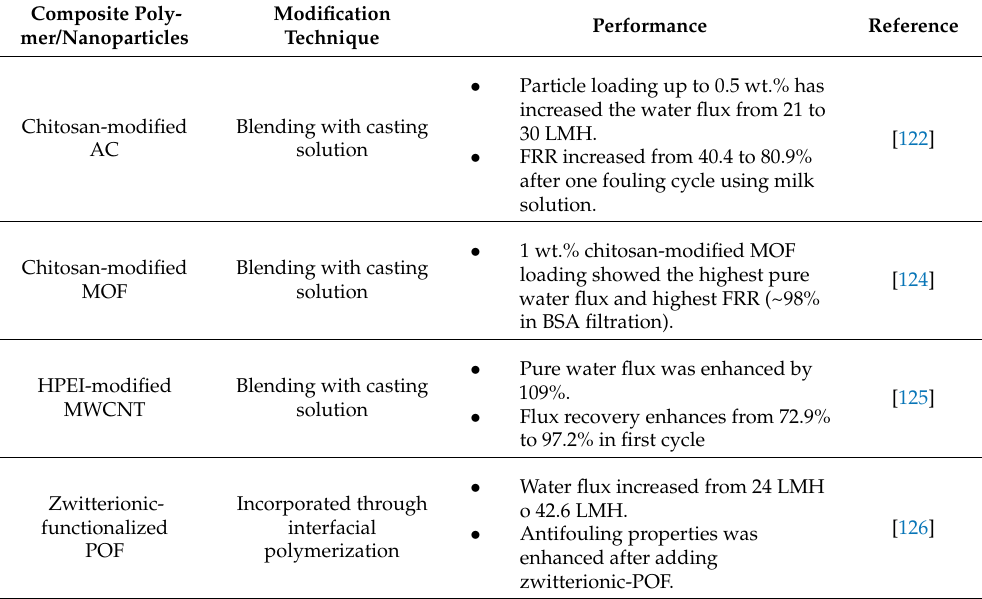
Table 3. NF modification using various composite